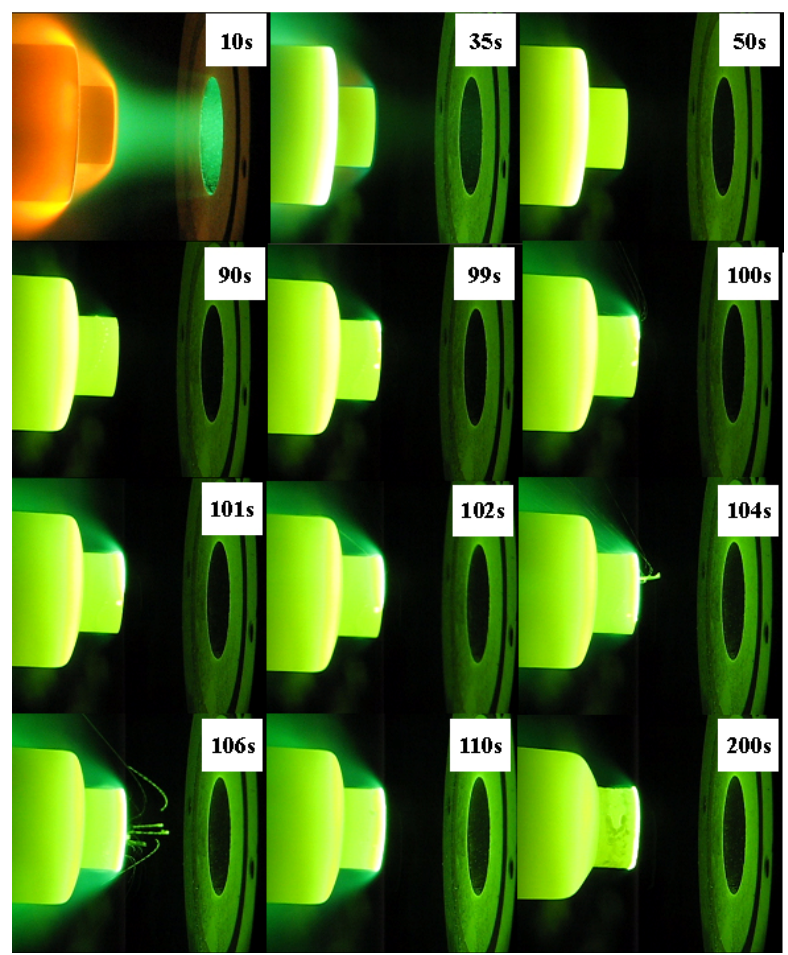
Figure 2. Images of ZS10 during ablation tests under condition 1.